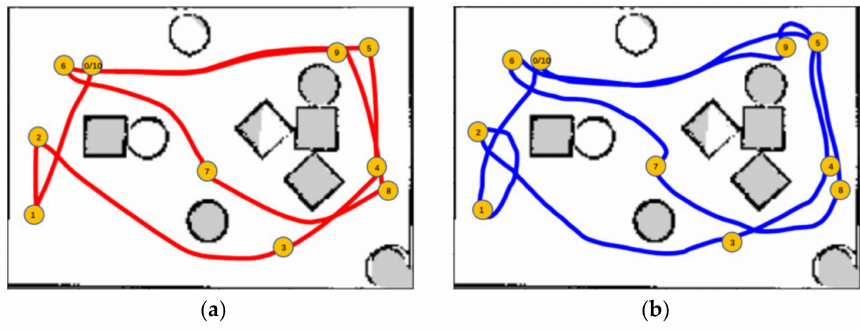
Figure 9. The trajectories generated by Move_Base and MDRLAT. ( a ) Move_Base ( b ) MDRLAT.